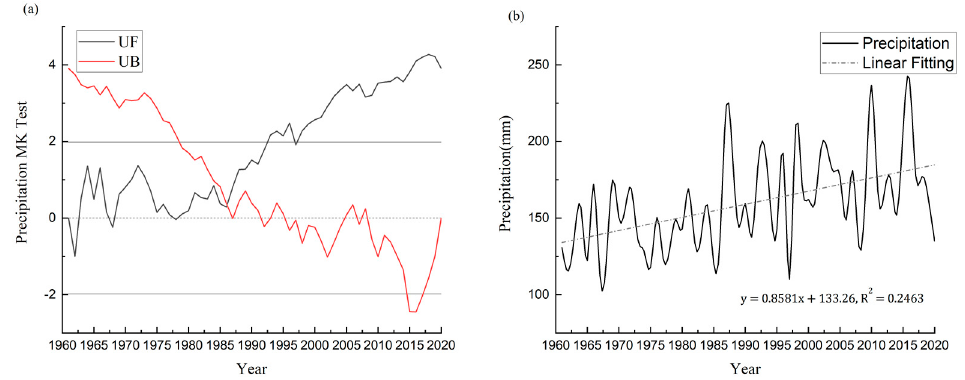
Figure 3. M − K mutation test ( a ) and trend analysis of the precipitation ( b ) in Xinjiang.